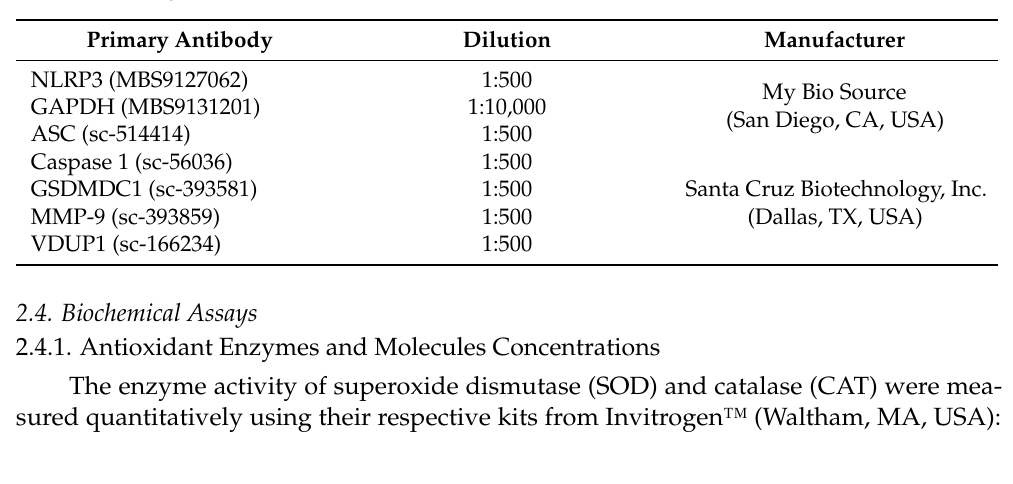
Table 1. Primary antibodies used for Western